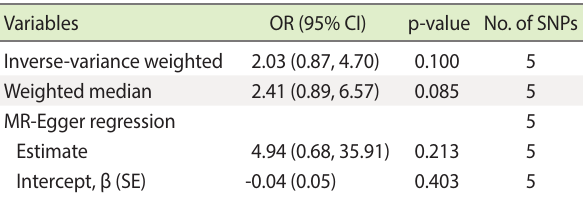
C: age, sex, BMI, alcohol consumption, smoking,